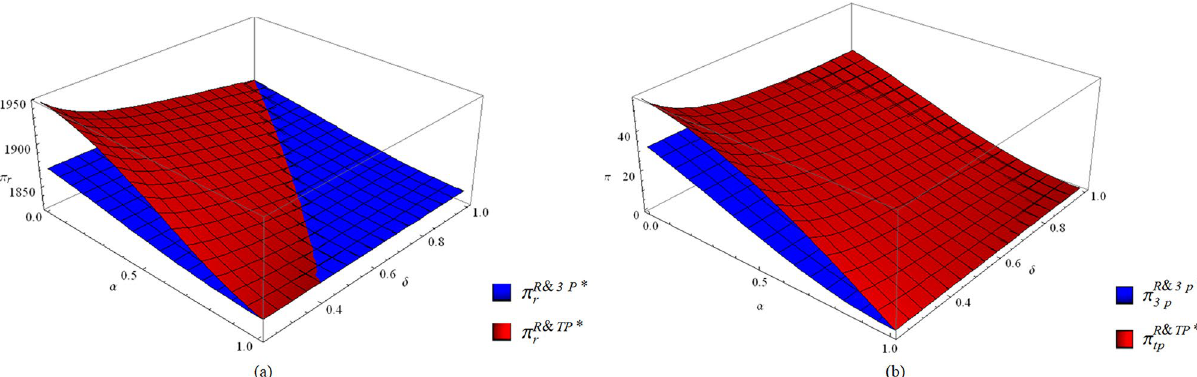
Figure 7. The profits of the retailer ( a ) and the third-party collector ( b ) with or without third-party economies of